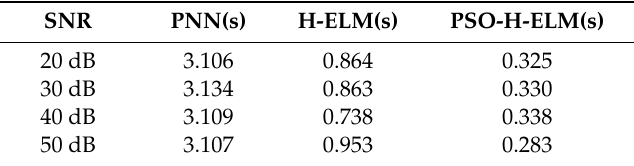
Table 3. Algorithm running time comparison. SNR, signal-to-noise ratio; PNN, probabilistic neural networks.